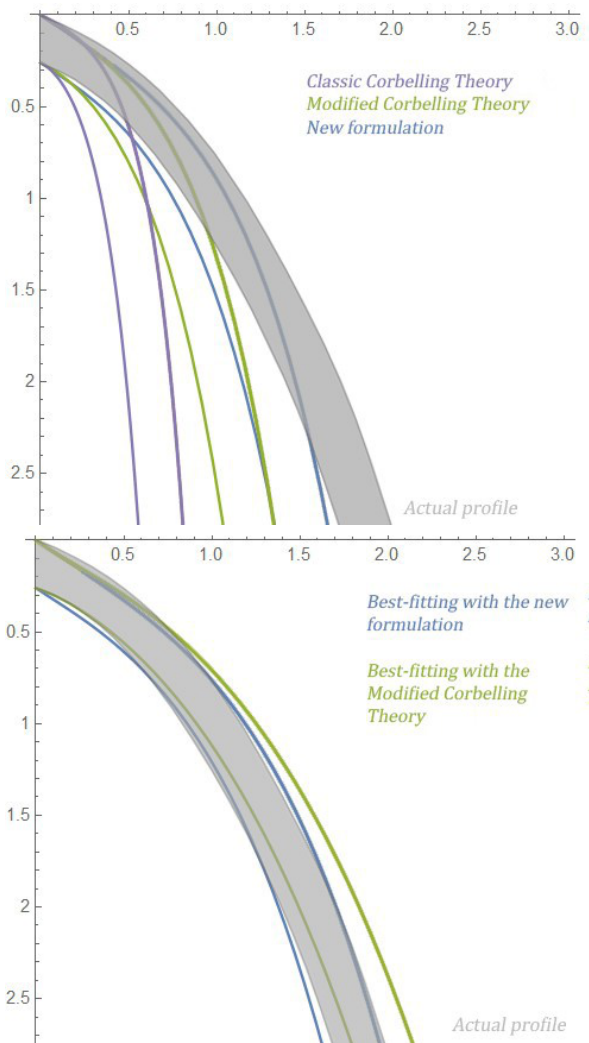
Figure 3: Comparison between the classic Corbelling Theory (CT), the Modified Corbelling Theory (MCT) and the new formulation of the Modified Corbelling Theory (NFMCT): (a) MCT and NFMCT best- fitting solutions; (b) CT, MCT and NFMCT solutions (the latter two are obtained for φ = 50 ∘ ) [2].